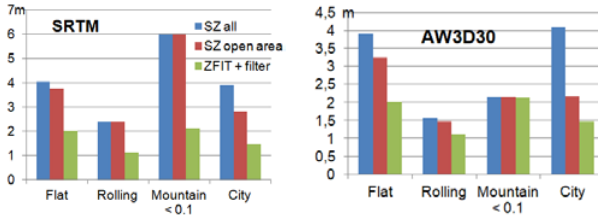
Figure 24. Standard deviation of SRTM and AW3D30 DSM